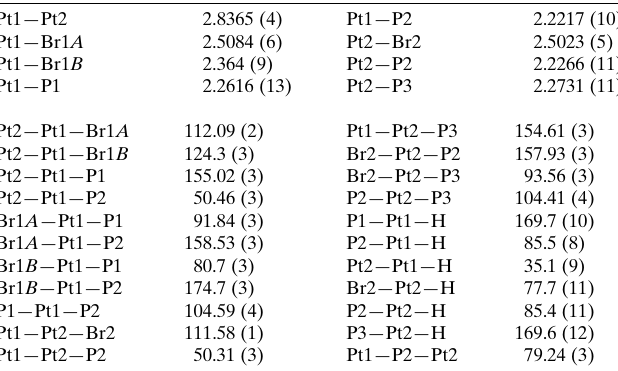
Table 1 Selected geometric parameters (A˚ , (cid:3) ).